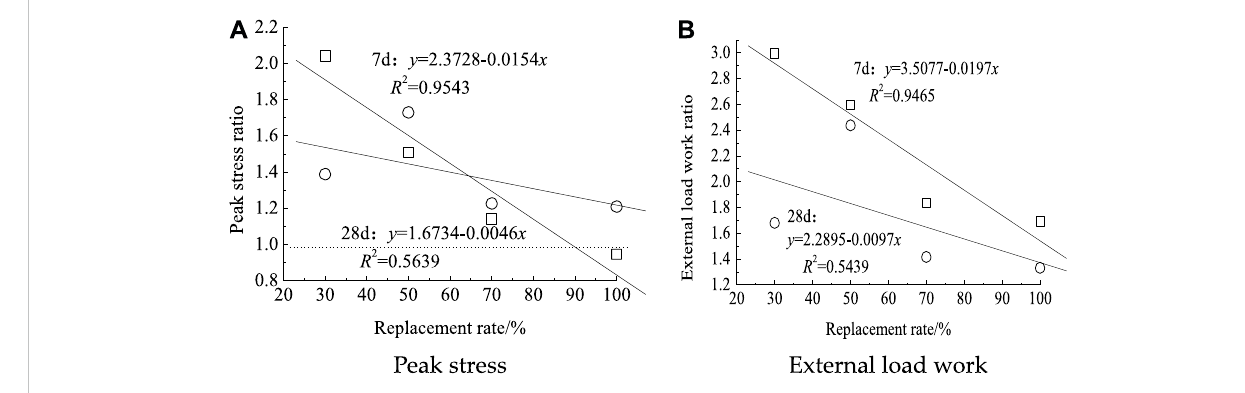
FIGURE 11 Peak stress and external load work of mortar at 7 days and 28 days.